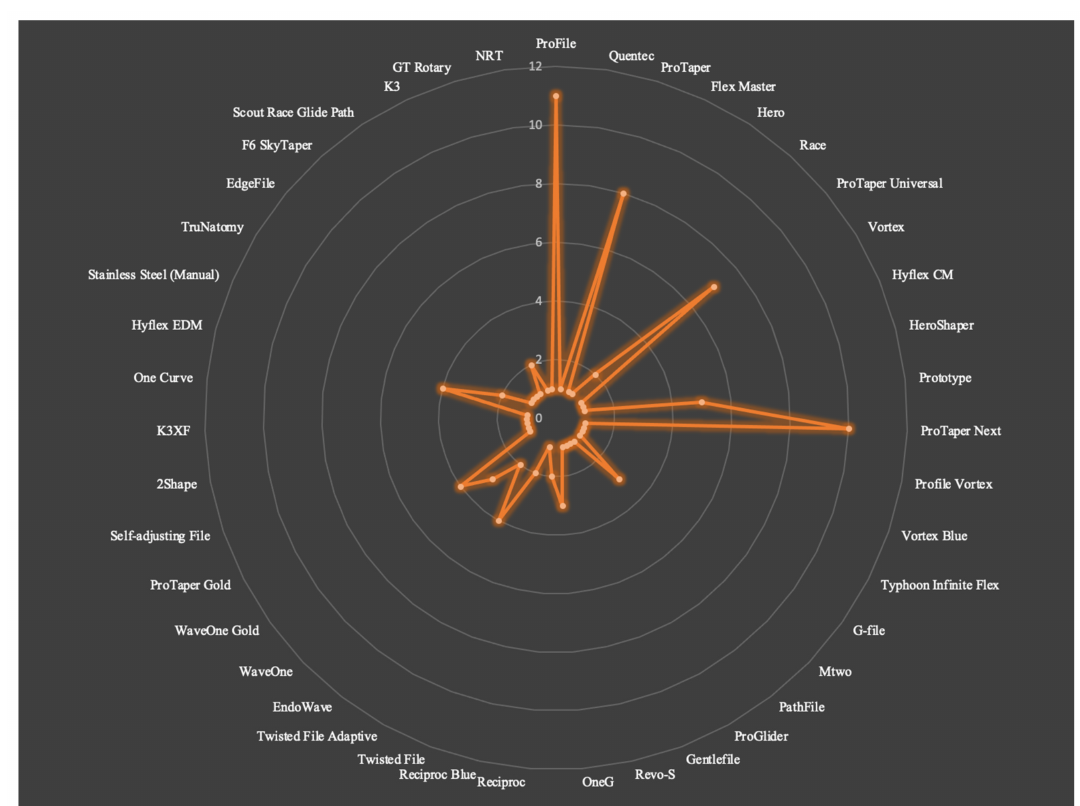
Figure 2. Instrument systems used in the studies included in the review.